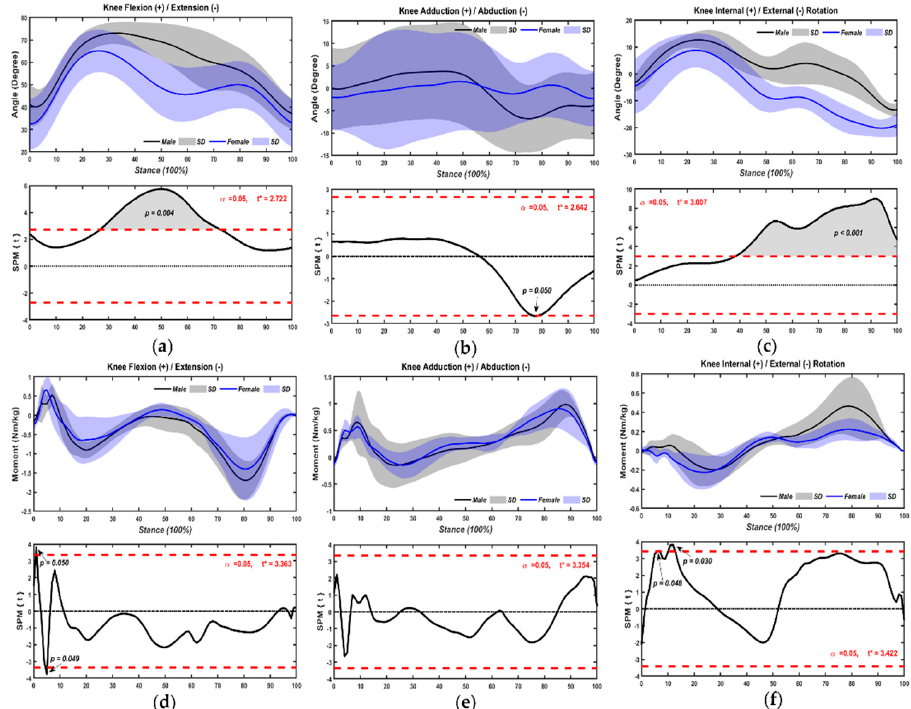
Figure 5. Kinematics (( a ), flexion/extension angle; ( b ), adduction/abduction angle; ( c ), internal/external rotation angle) and kinetics (( d ), flexion/extension moment; ( e ), adduction/abduction moment; ( f ), internal/external rotation moment) of knee joint with chasse-step in sexes.